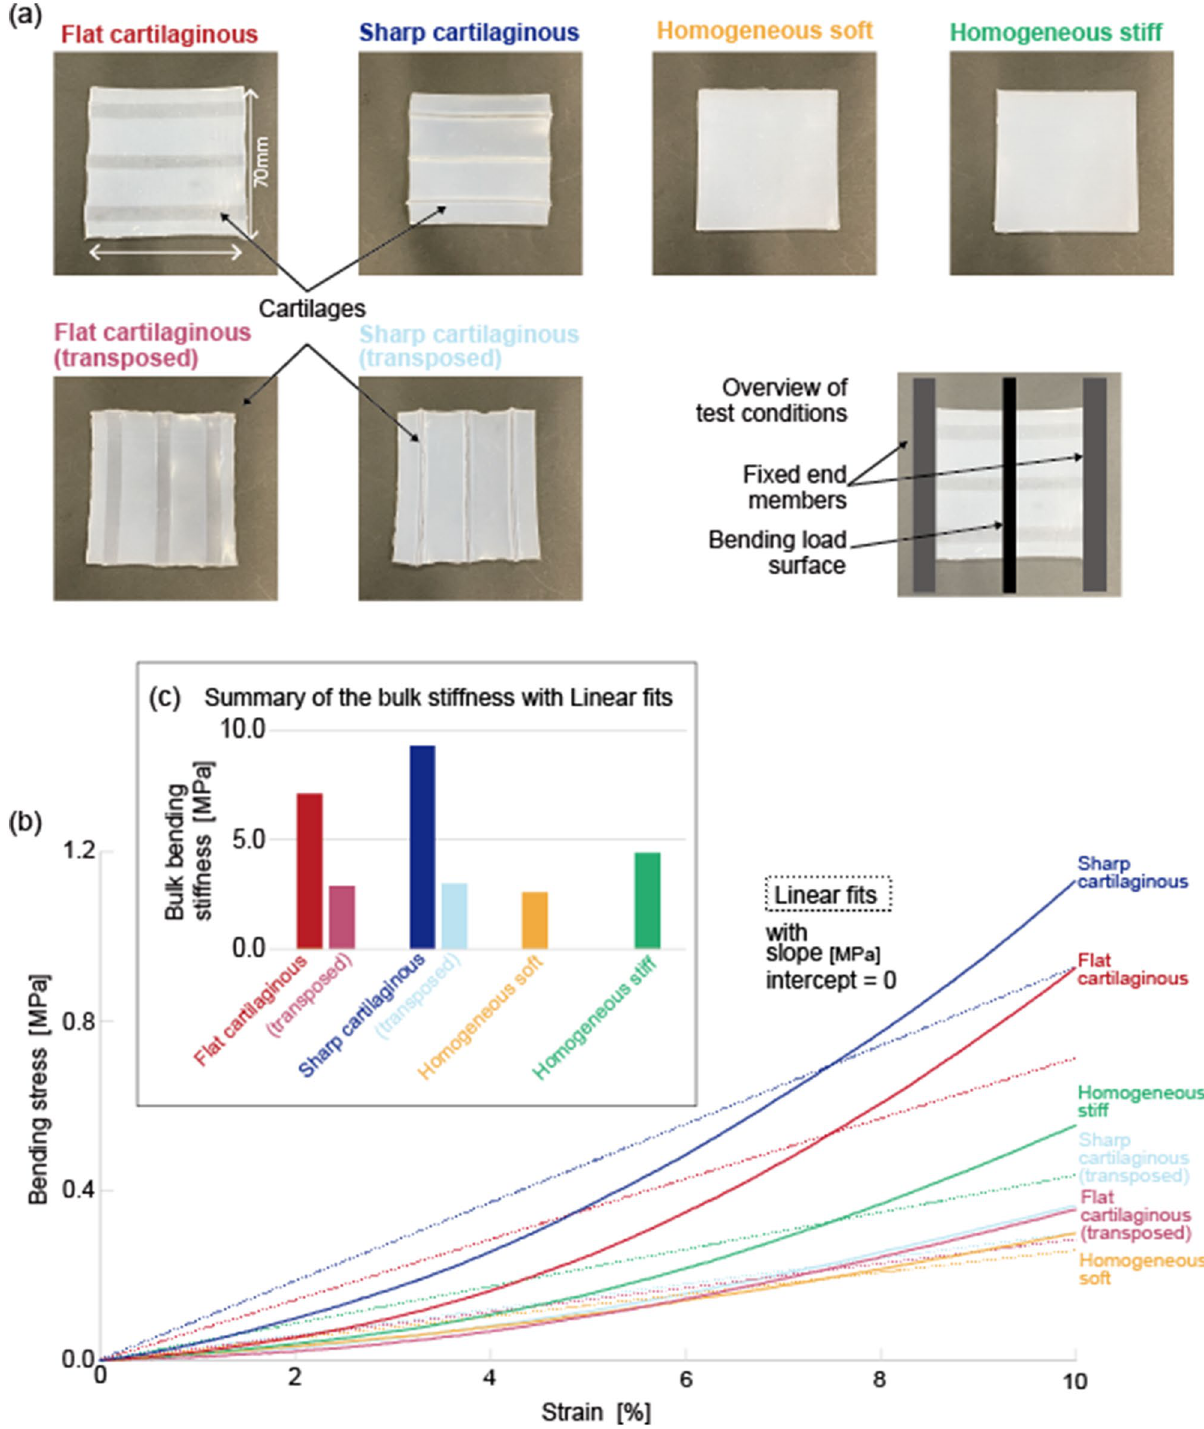
Figure 3. Results of bulk bending tests of specimens. ( a ) Top view of six types of specimens: Flat cartilaginous, Sharp cartilaginous, Homogeneous soft, Homogeneous rigid, and Flat cartilaginous, Sharp cartilaginous consisting of the same silicone elastomers taken for comparison. The composition and structure of Flat cartilaginous (Sharp cartilaginous) and Flat cartilaginous (Sharp cartilaginous) samples are the same, whereas the direction of cartilages is parallel and perpendicular to the strain direction. Sharp cartilaginous with a height of 6 mm consist of the cartilages with a sharper shape as compared to Flat cartilaginous with a height of 1 mm. Homogeneous soft sample is without cartilages, whereas Homogeneous rigid is a mixture of the soft tissue and cartilage materials. ( b ) Stress–strain curves of the specimens. The solid lines are the measured data, and the corresponding dashed lines are linear approximations. ( c ) The bulk stiffness of each specimen obtained as the stress to strain ratio at 1%